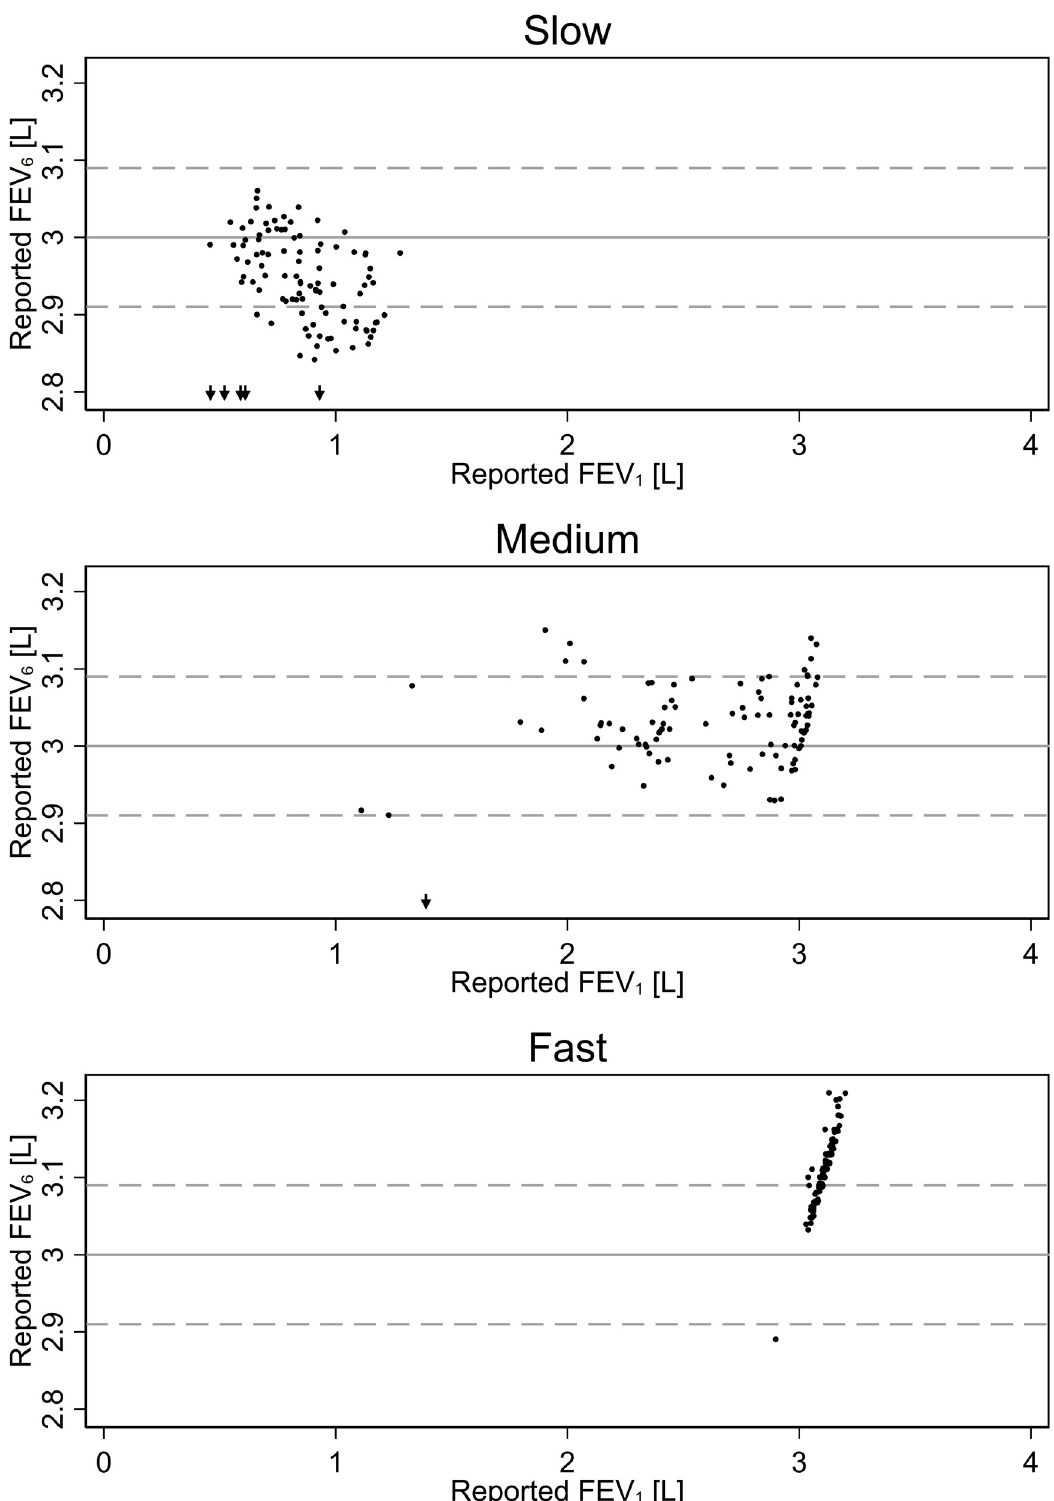
Fig 3. Scatterplots of calibration check data for copd-6, stratified by the speed of pushing the piston of the calibration syringe. Spearman’s % = 0.82, p < 0.001. Each dot represents one plunge of the calibration syringe. Arrows pointing downward are plunges with reported FEV 6 < 2.8 liters. Gray lines located at 3.00 liters ± 3%.